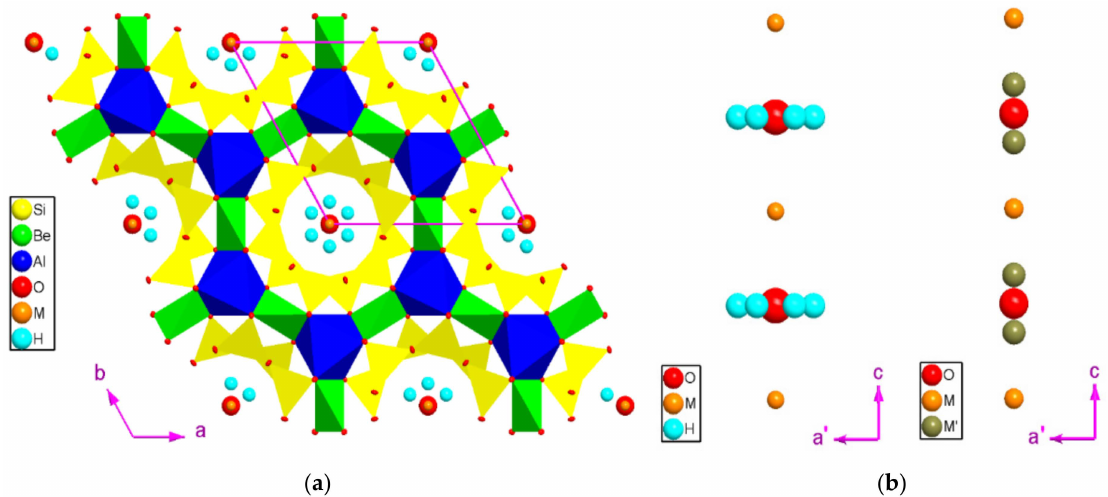
Figure 1. ( a ) The crystal structure of beryl based on the structure refinement of the samples of this study. ( b ) Schematic configuration (with arbitrary ionic radii) of the channel sites along [001] obtained for the BS1R, BS2G, and BS3G samples (i.e., with the H site) and for the BN1R sample (i.e., without the H